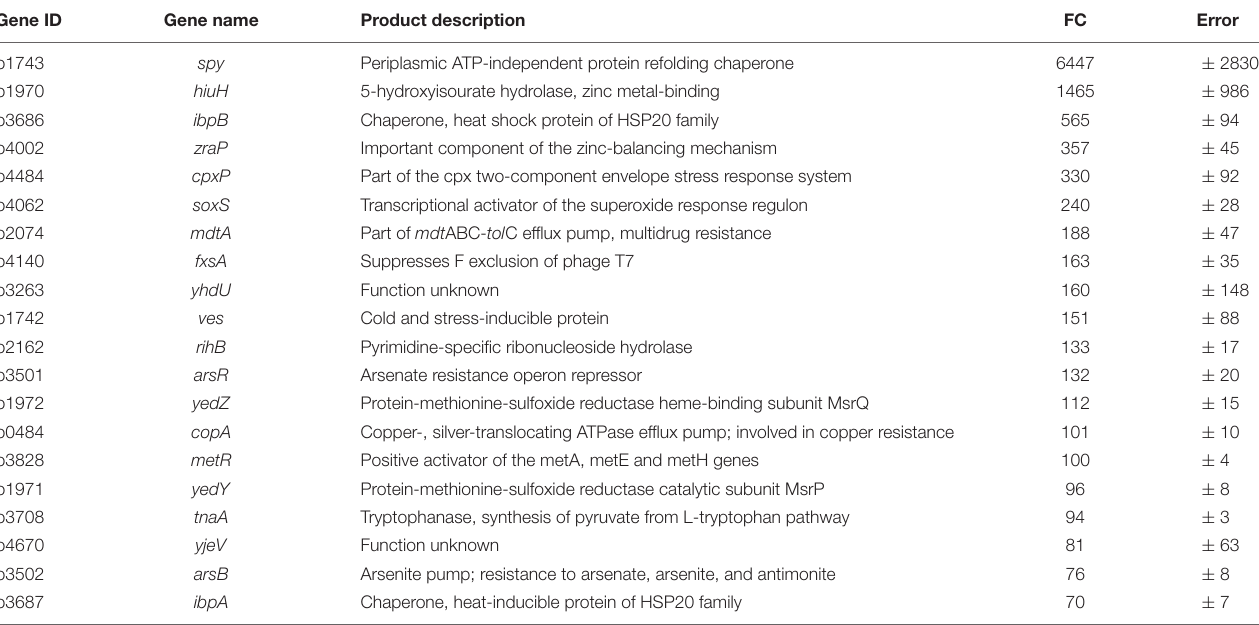
TABLE 2 | Top 20 most up-regulated genes after 10 min of exposure to 100 µ M Pd.